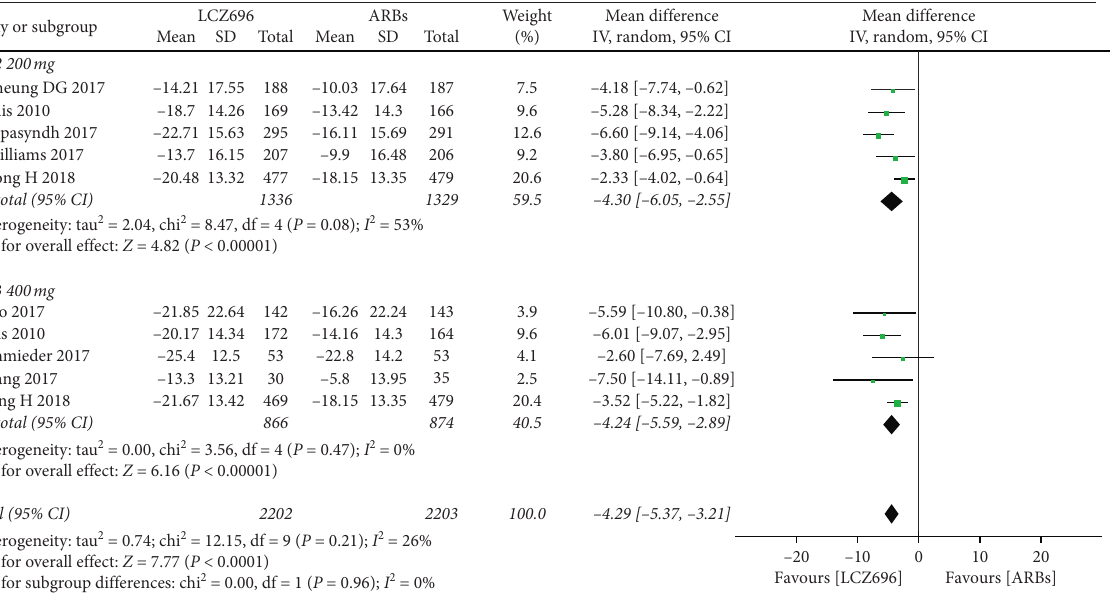
Figure 3: Comparison of LCZ696 with ARBs on mean reduction (mm Hg) in sitting systolic blood pressure (msSBP).